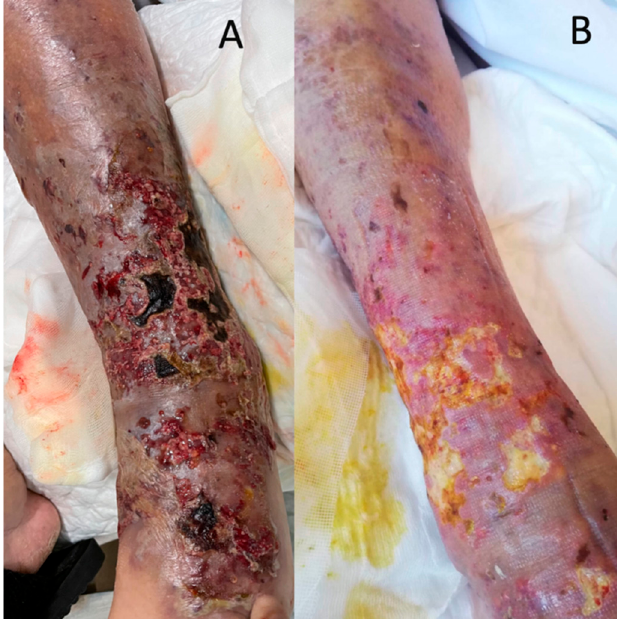
Figure 1. ( A ) Exudative necrohemorrhagic lesions located in the lower third of the left leg. Patchy involvement can be observed on healthy skin with a tendency to violaceous coloration. ( B ) Evolu- tion of cellulitis lesions in left leg after systemic treatment with caspofungin. Disappearance of necrohemorrhagic lesions and improvement in color and appearance of the surrounding skin can be observed.